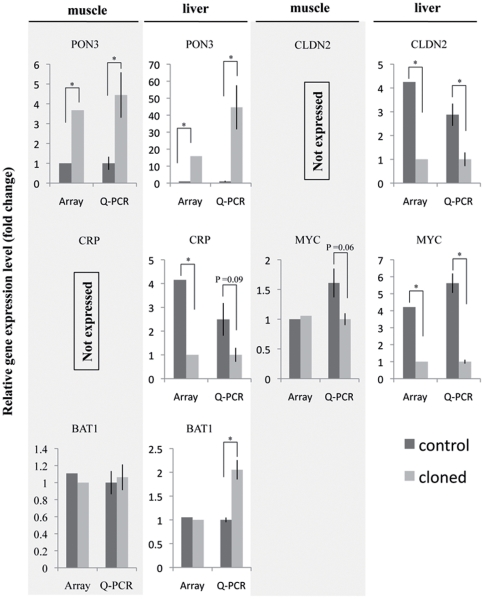
Q-PCR validation of differentially expressed gene found by microarray.Quantitative real time PCR was used to validate the gene expression of PON3, CLDN2, CRP, MYC, and BAT1 in muscle and liver by microarray. Relative gene expression level for Q-PCR was first normalized to the reference gene (Beta-Actin), and then calculated as fold changes to the sample, in which the gene expression level is the lowest. Fold changes of gene expression from microarray were plotted together with the Q-PCR results. Results were shown as Mean ± SE (duplicate). “*” represents p value<0.05 by ttest.